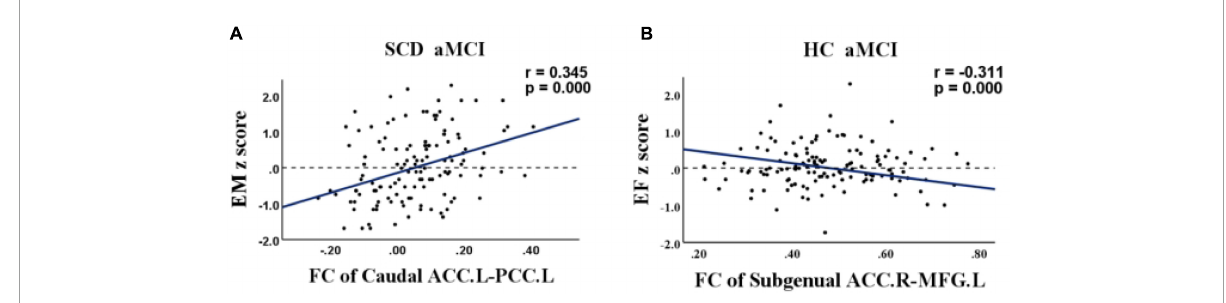
FIGURE5 Relationship between abnormal anterior cingulate cortex subregions functional connectivity and cognition in healthy control (HC), subjective cognitive decline (SCD), and amnestic mild cognitive impairment (aMCI). (A) Relationship between functional connectivity (FC) of the left caudal anterior cingulate cortex and the left posterior cingulate and episodic memory in patients with SCD and aMCI. (B) Relationship between FC of the right subgenual anterior cingulate cortex and the left medial frontal gyrus and executive function in patients with HC and aMCI. FC, functional connectivity; HC, healthy controls; SCD, subjective cognitive decline; aMCI, amnestic mild cognitive impairment; ACC, anterior cingulate cortex; PCC, posterior cingulate; MFG, medial frontal gyrus; EM, episodic memory; EF, executive function.